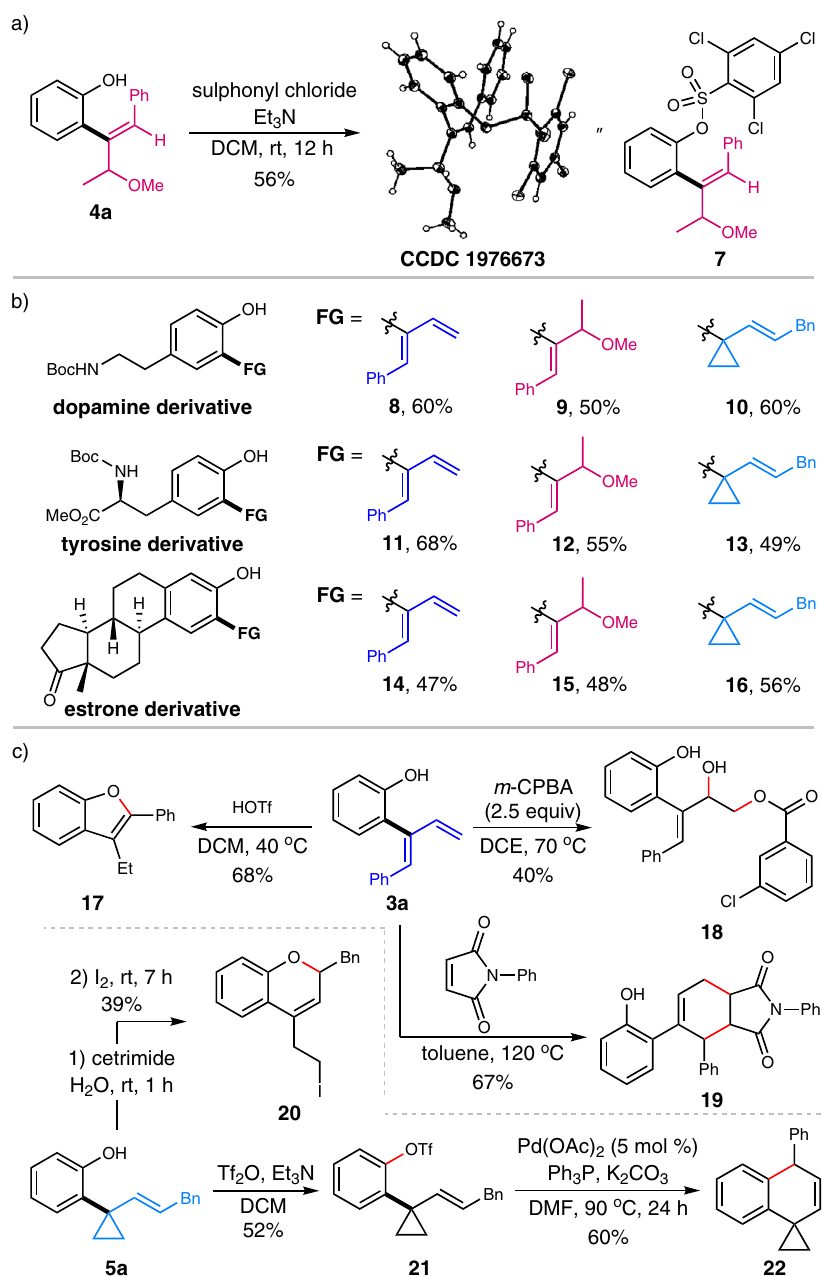
Fig. 6 Synthetic applications. a Determination of the con fi guration. b Late-stage C – H modi fi cation of natural products. c Derivatizations of the